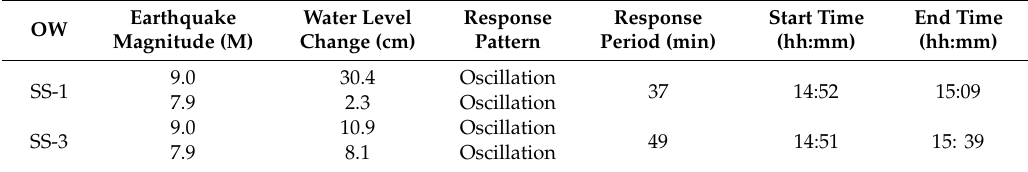
Figure 4. Changes in groundwater level caused by the M 9.0 Tohoku-Oki earthquake and the M 7.9 aftershock in wells SS-1 and SS-3. Table 2. Groundwater level changes due to the 2011 M 9.0 Tohoku-Oki earthquake and its M 7.9